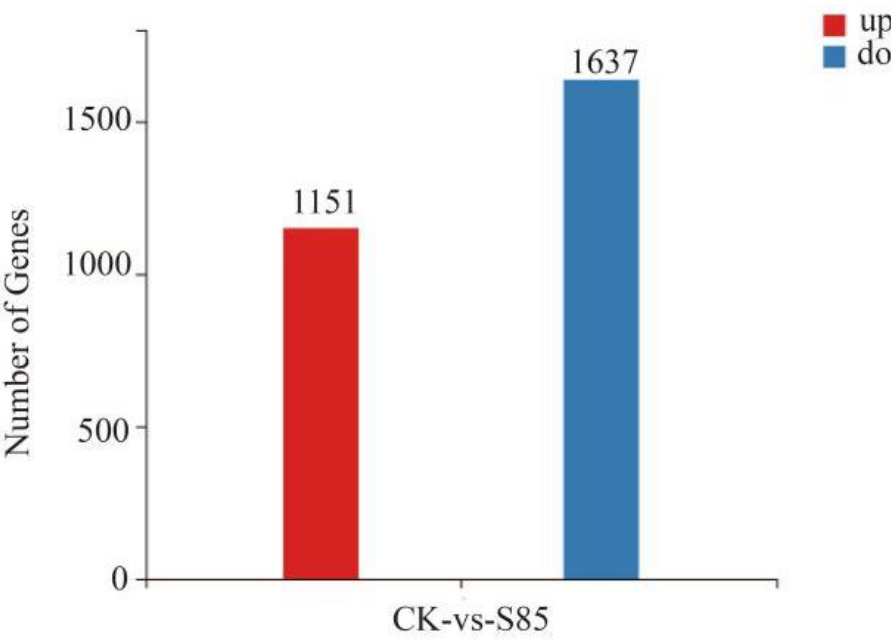
Figure 5. Number of differentially expressed genes between the control and S85 treatment groups. 2.6. Gene Ontology (GO) and Kyoto Encyclopedia of Genes and Genomes (KEGG) Enrichment Analyses of the Differentially Expressed